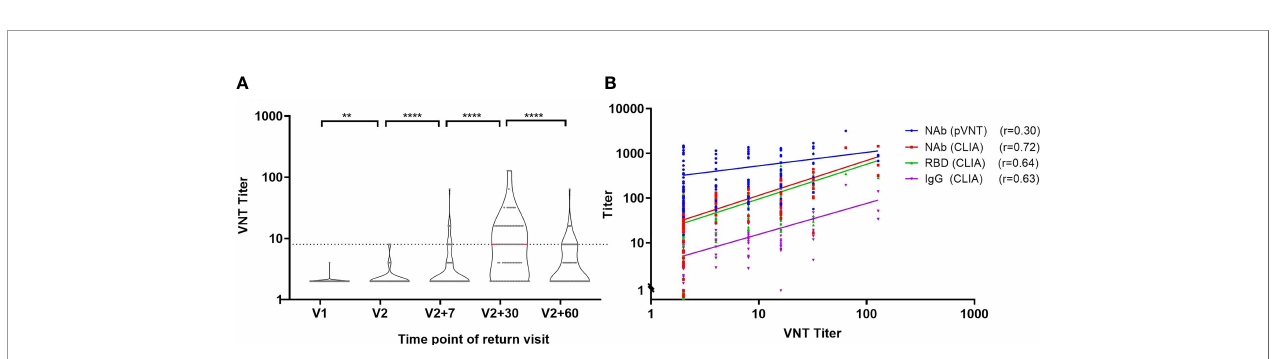
FIGURE 5 | Correlation analysis of CLIA, VNT and pVNT antibody detection. (A) Trend of VNT titer over time. (B) Correlation between neutralizing antibodies detected by VNT and pVNT and NAb, RBD and IgG antibodies detected by CLIA. r: Spearman correlation coef fi cient. **P ≤ 0.01. ****P ≤ 0.0001 (Mann-Whitney U